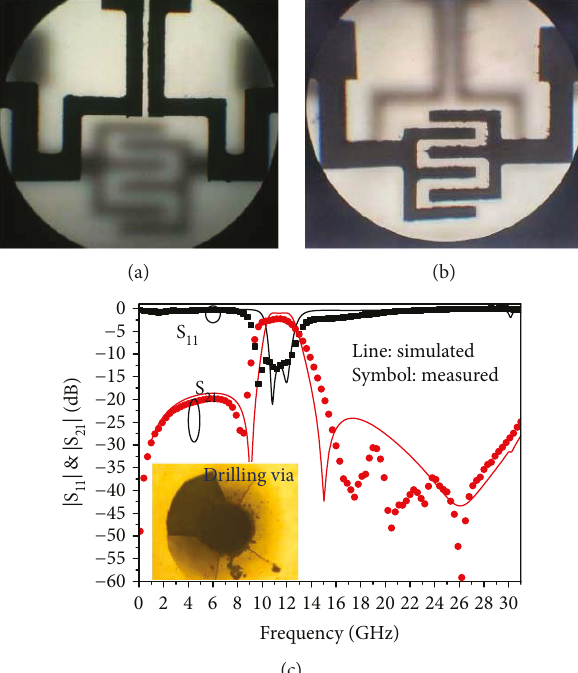
Figure 9: Photographs of the bandpass fi lter on (a) layer 1 and (b) layer 2. (c) S-parameters of the interdigital bandpass fi